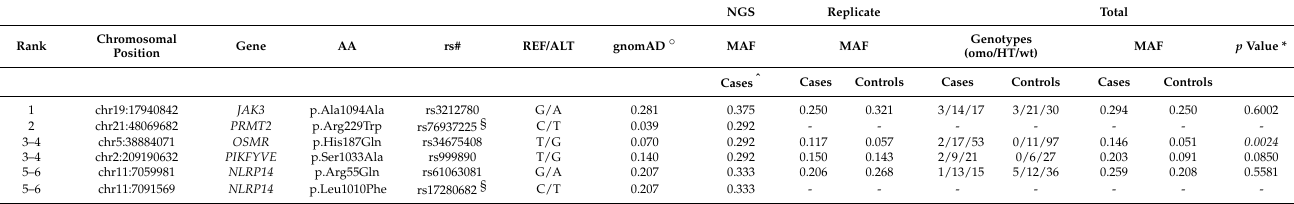
◦ Non Finnish European controls; ˆ Minor allele frequency (MAF) in controls was 0 for all the selected variants; * Fisher’s exact test p -values on NGS + replicate data; significant p -values ( p < 0.05) are in italics; § rs76937225 (PRMT2) was not confirmed in one patients, rs17280682 (NLRP14) was not validated because in complete linkage disequilibrium (LD) with the selected variant rs61063081.